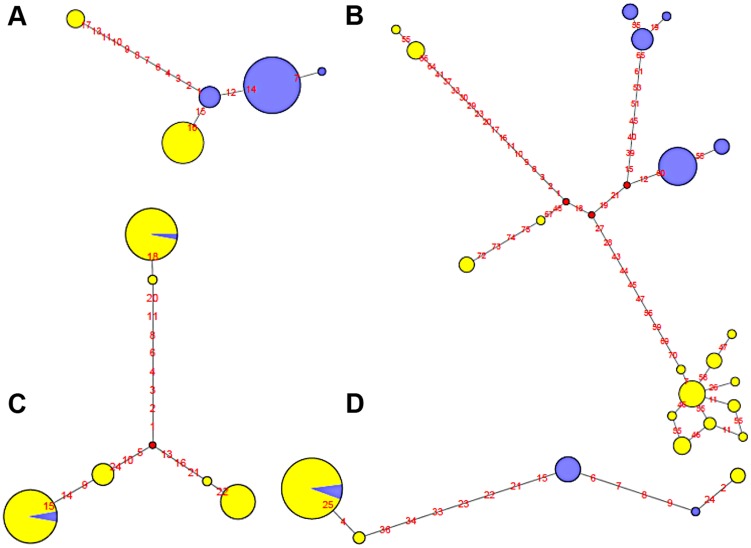
Haplotype network of four human polymorphic inversions from phased HapMap SNP data showing unique or recurrent origins.
A. HsInv0114. B. HsInv0286. C. HsInv0341. D. HsInv0389. Circles correspond to the different haplotypes found for the region of the inversion and circle sizes are proportional to the frequency of each haplotype. Std and Inv haplotypes are represented in yellow and blue, respectively. Small red circles represent hypothetical haplotypes. Nucleotide changes between haplotypes are indicated as red numbers.